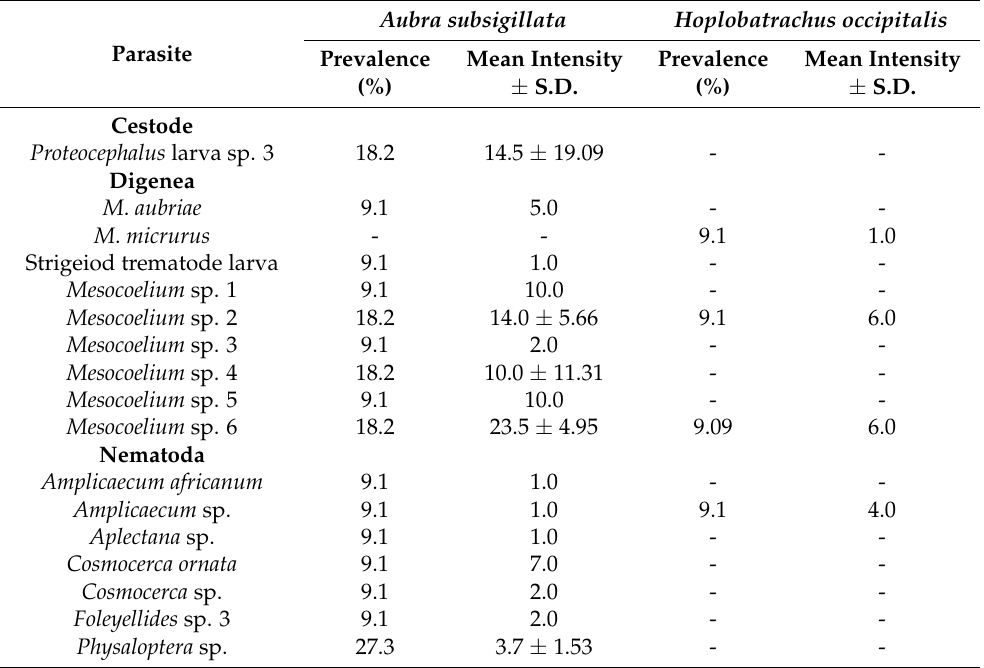
Table 1. Prevalence and mean intensity of helminths in Aubra subsigillata and Hoplobatrachus occipitalis from cocoa plantations in Ojo camp,